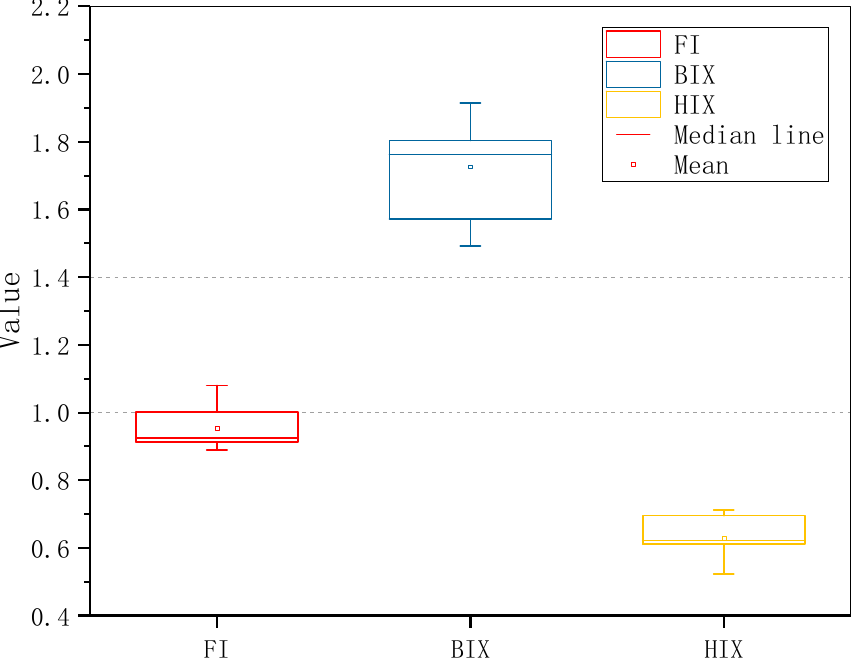
Figure 6. Box charts of FI, BIX and HIX of 10 CBM produced water samples. The whisker line represents 1.5 times the inter-quartile range, from which can judge that the dispersion of fluorescence index of each sample is low.